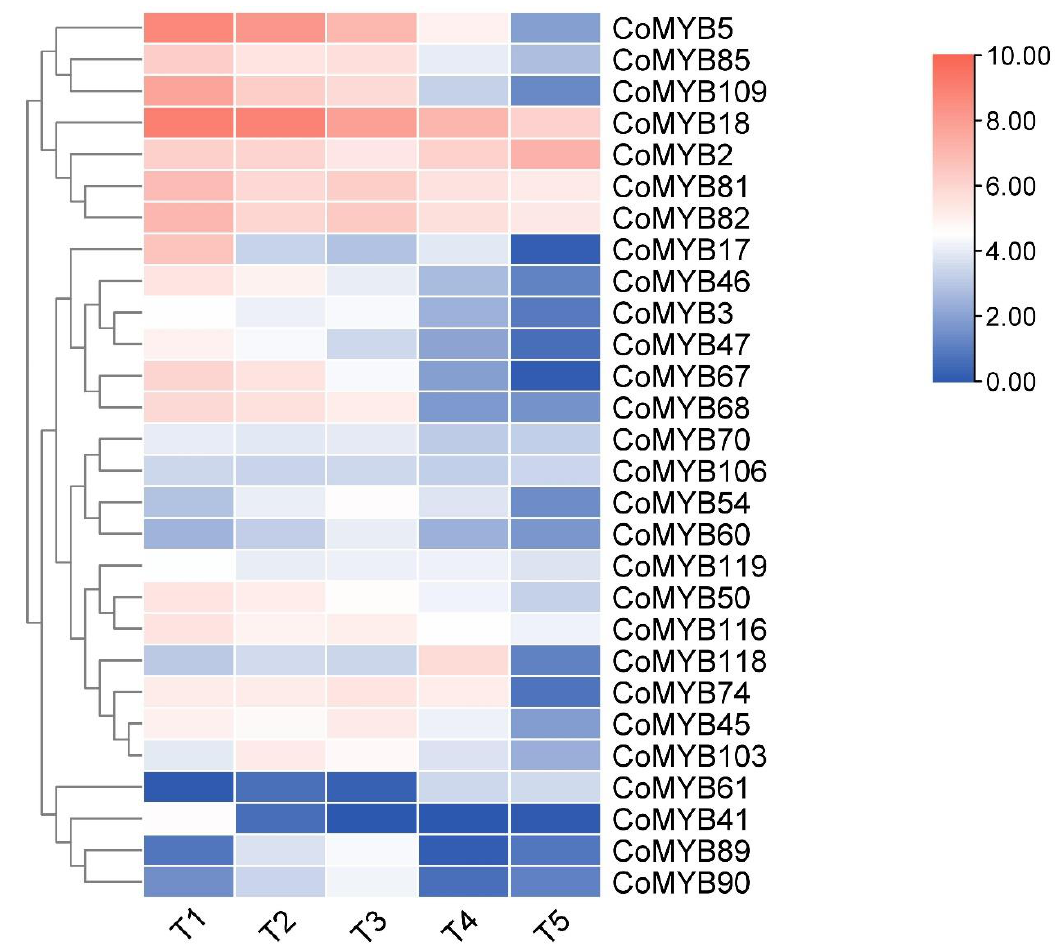
Figure 6. Hierarchical clustering of the expression patterns of 28 R2R3-MYBs in C. oleifera at five different stages of seed development. Red means high expression, and blue means low expression. The five developmental stages of seeds were T1 (210 DAP, days after pollination), T2 (235 DAP), T3 (258 DAP), T4 (292 DAP), and T5 (333 DAP). The oil content gradually increased from T1 to T5 and reached the highest at T5.